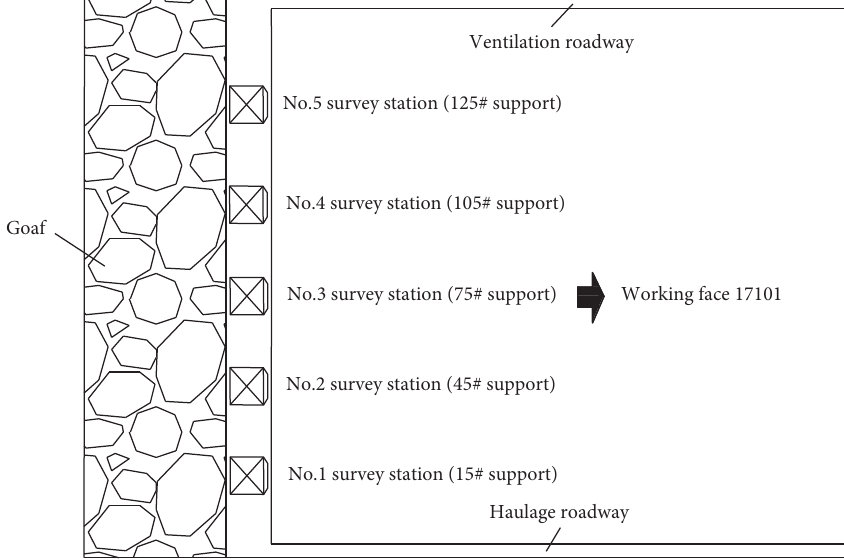
Figure 3: Layout of mine pressure observation stations at working face 17101 under repeated mining. Table 1: Distribution range of face-end roof caving at each station.